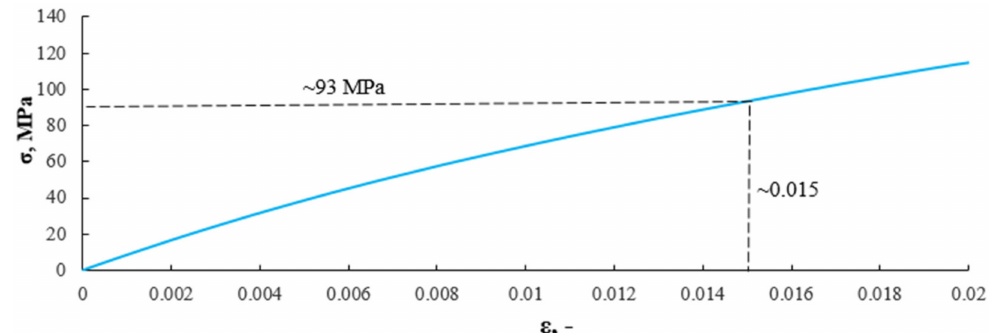
Figure 13. Determination of stress value on a composite sample with a 10% recyclate content and 1.2 mm in grain size corresponding to strain ε = 0.015 (99 s of time in Figure